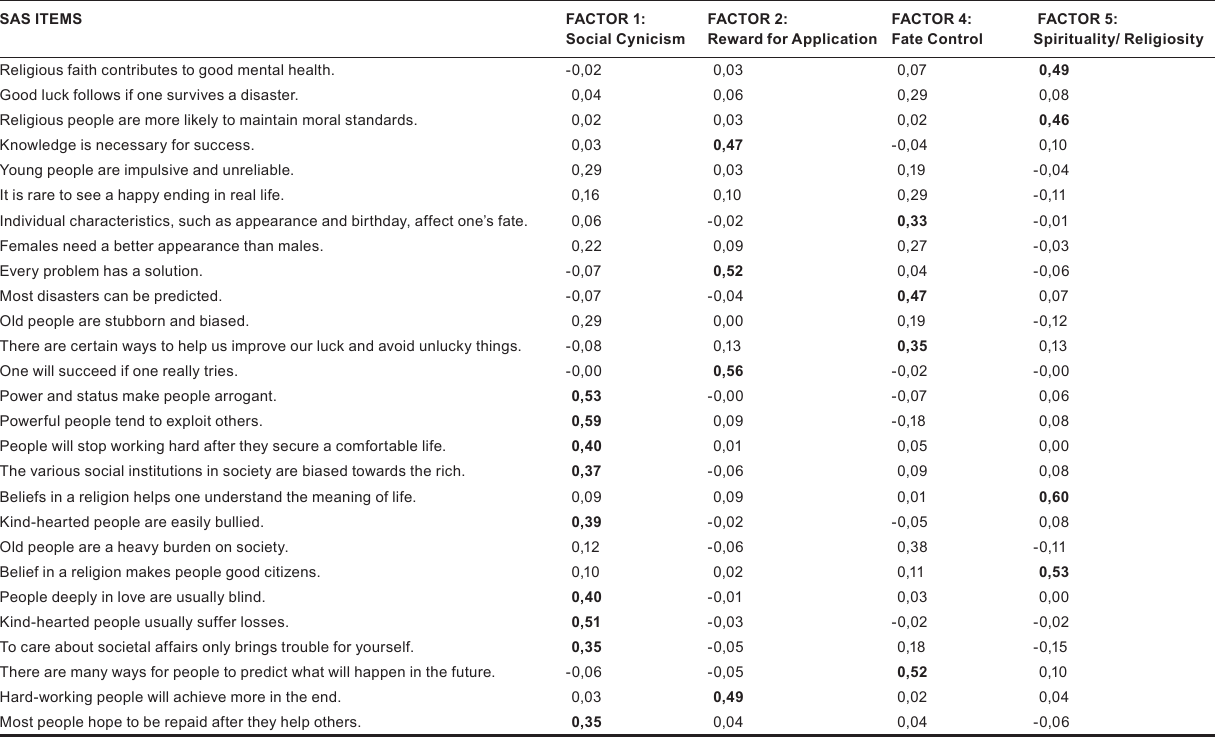
tABLe 3 Values of Tucker’s phi for the factors of the SAS factor analysis for seven language groups Zulu Sotho tswana Swati tsonga Venda Pedi Factor 1: Social Cynicism Factor 2: 0,98 0,99 Reward for Application